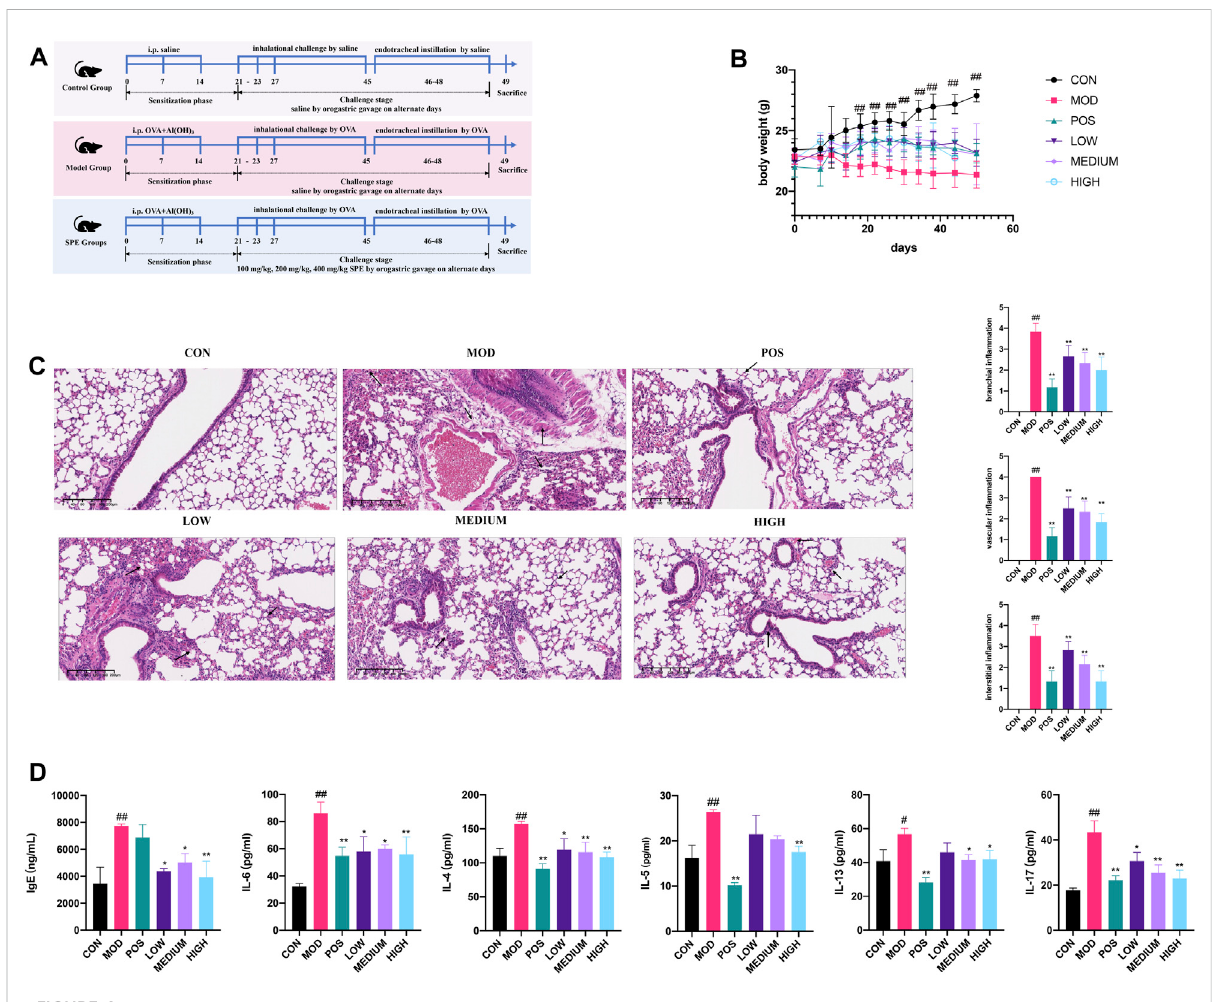
FIGURE 4 Validation of the PEF against asthma. (A) Timeline of the animal experimental protocol. (B) Body weight records of the mice during the experiment (n = 6). (C) Representative images of HE staining (× 10) and in fl ammation scores. (D) Expressions of in fl ammatory cytokines in serum. (## p < 0.01 v. s. CON group. ** p < 0.01 v. s. MOD group. * p < 0.05 v. s. MOD